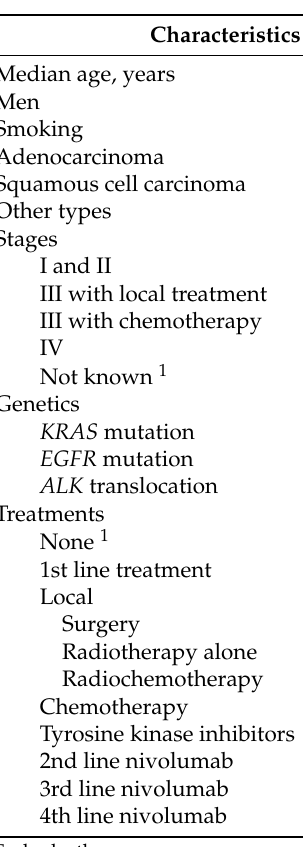
Table 1. Demographic and disease characteristics of the NSCLC cohort ( n =